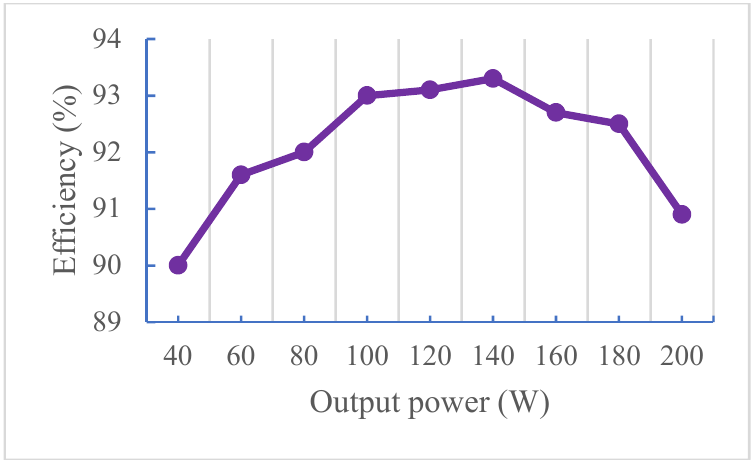
Figure 19. Power budget of the CHSDC.